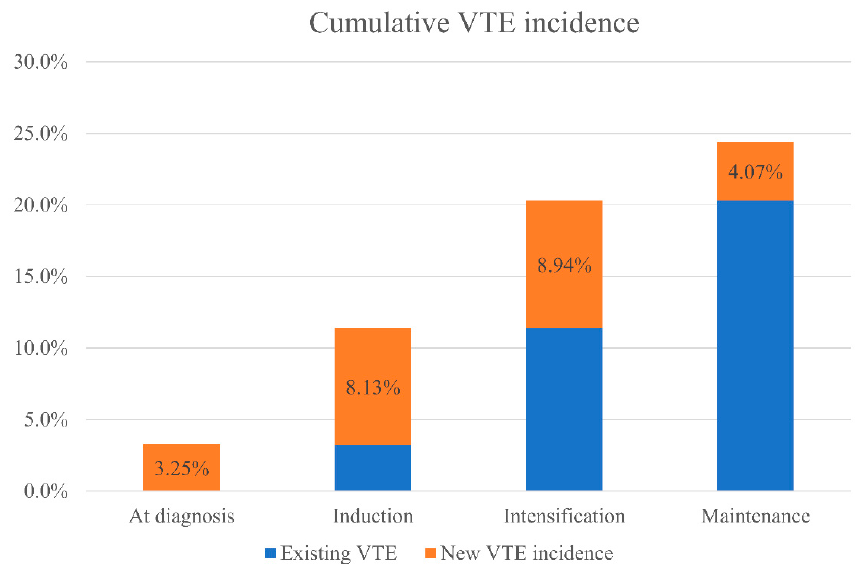
Figure 2. Overall temporal distribution of the 30 VTE events from diagnosis to the end of maintenance with respect to the whole cohort of 123 patients. The incidence was 3.25% (4 out of 123) at diagnosis, 8.13% (10 out of 123) during induction, 8.94% (11 out of 123) during intensification, and 4.07% (5 out of 123) during maintenance. Table 2. Characteristics of patients with venous thromboembolism